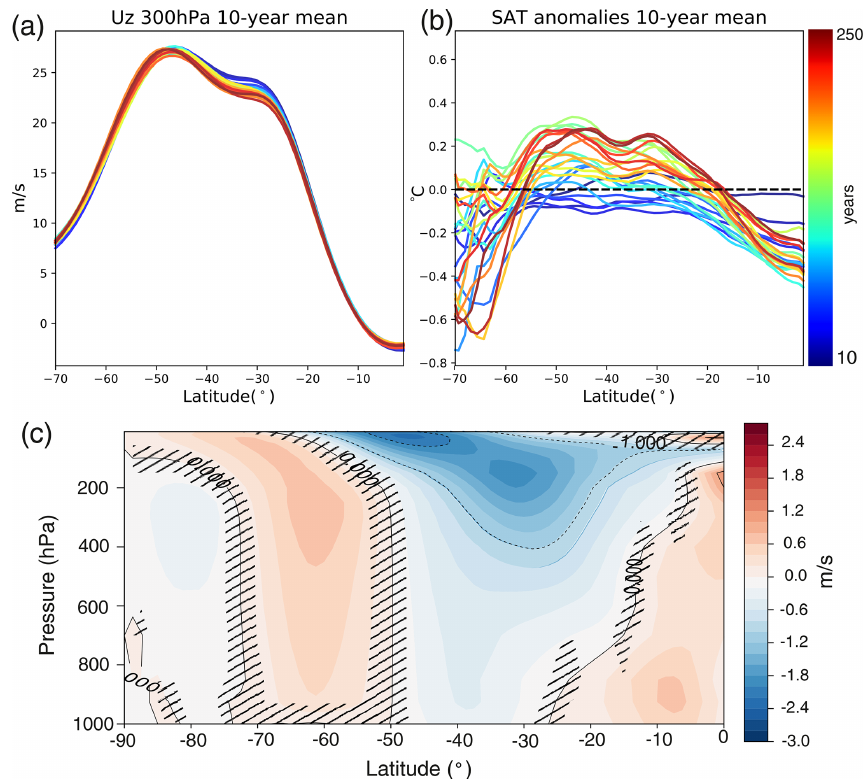
Figure 7. As in Fig. 6 but for the Southern